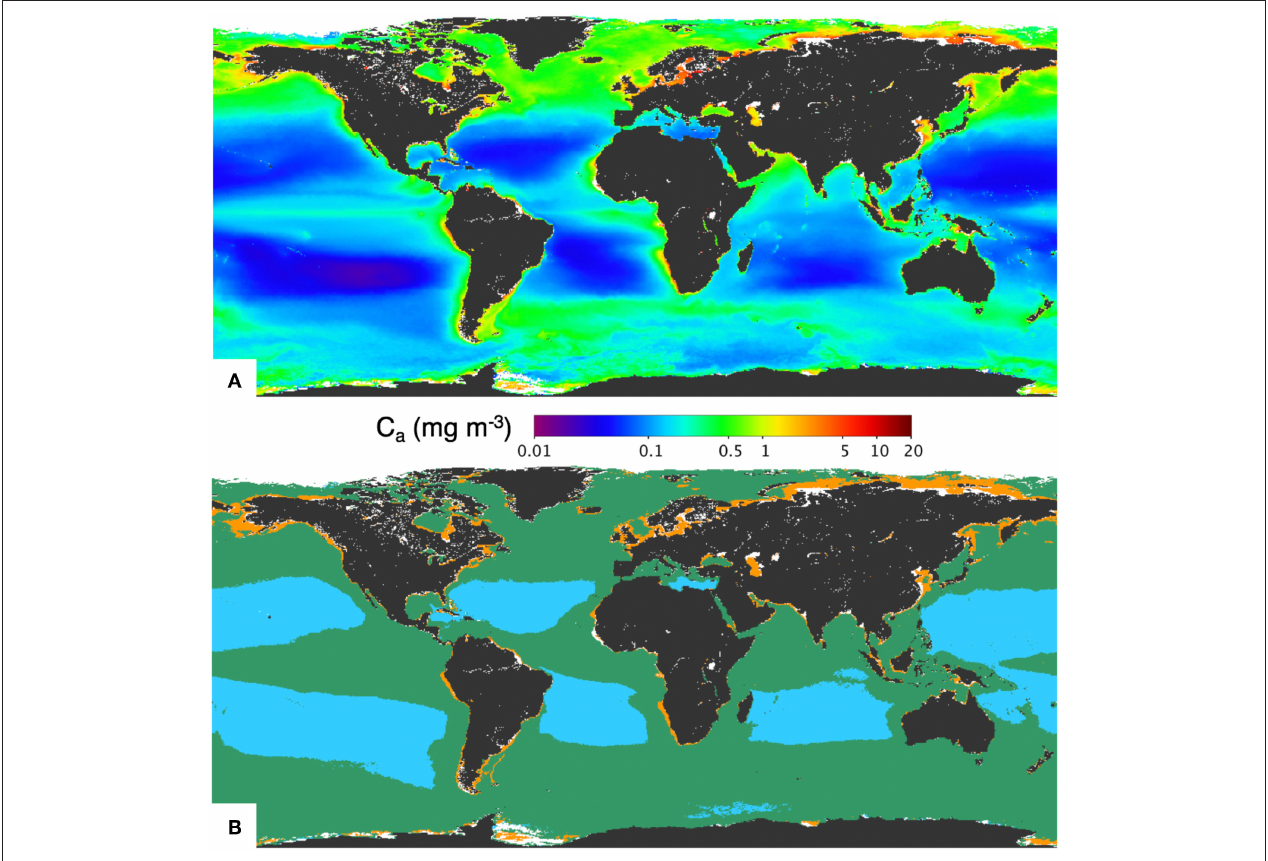
FIGURE 7 | SeaWiFS C a calculated using mission-long R rs ( λ ) as input into the OCI algorithm (Hu et al., 2012) (A) and the global spatial distribution of oligotrophic (cyan), mesotrophic (green), and eutrophic (orange) waters (B) . Black and white indicate land and SAA algorithm failure, respectively.